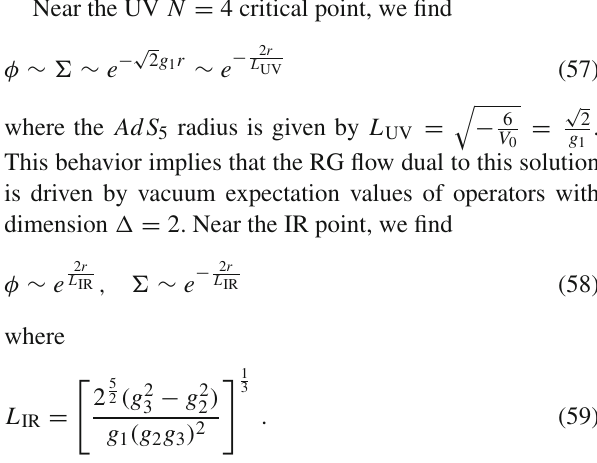
− 4 in Table 2 corresponds to (cid:2) . The massless scalars 3 Table 2 are Goldstone bosons corresponding to the symmetry breaking SU ( 2 ) × SU ( 2 ) → SU ( 2 ) diag .Themasslessscalars 5 0 are dual to marginal operators in the dual N = 2